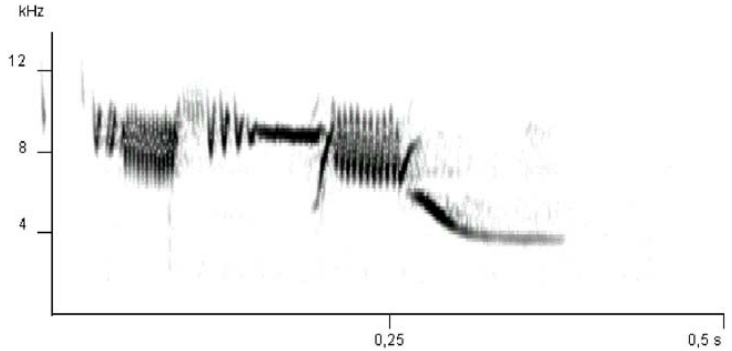
Fig. 2–BasicsongstructureoftheBlue-blackGrassquit Volatiniajacarina showing its single note compacted into a ‘‘window’’ between 2 and 13 kHz and rarely occupying more than half of a